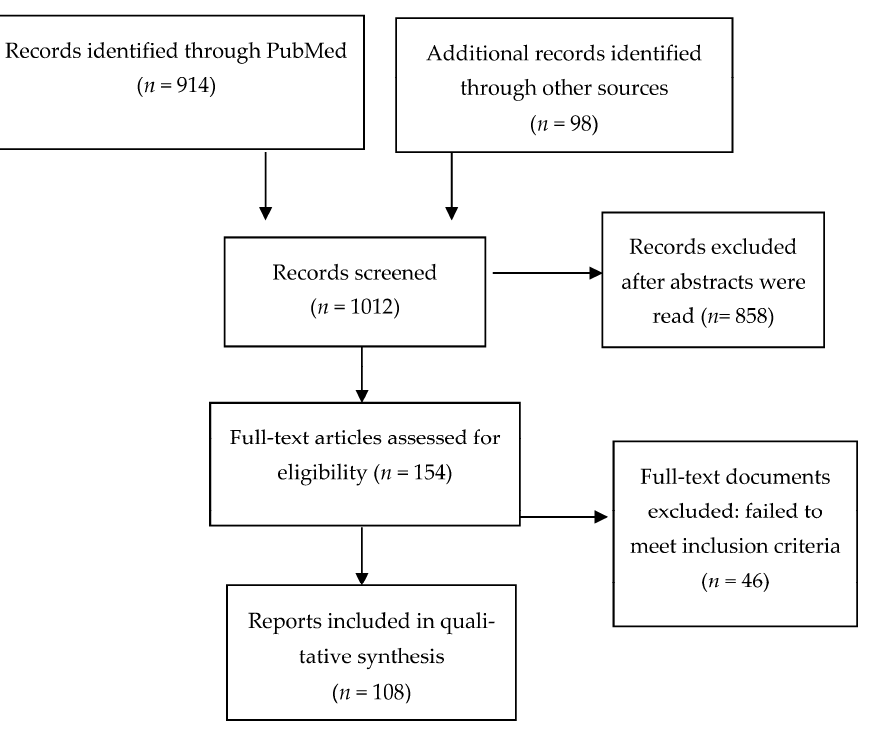
Figure 1. Flow diagram of the included studies.